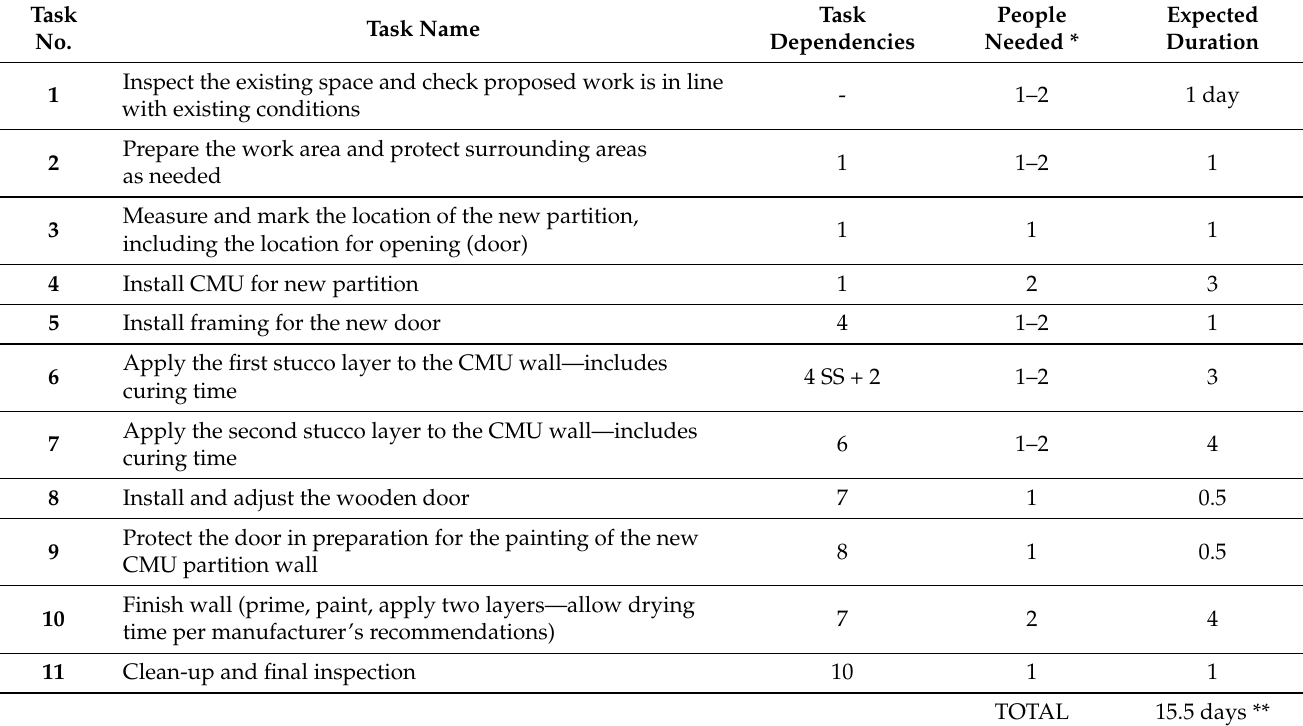
Table 2. List of tasks derived from the scope of work indicated in the original prompt and considered as the baseline for this